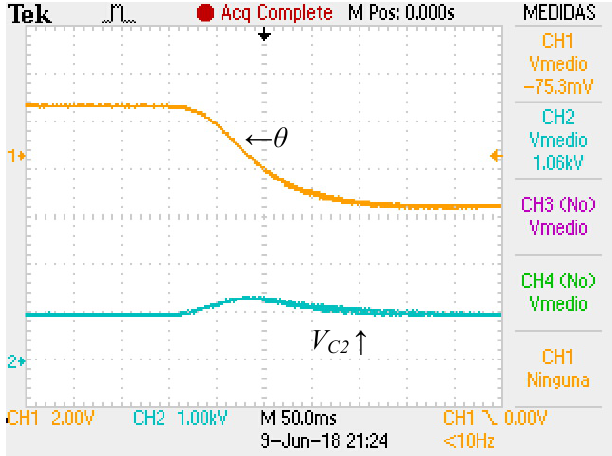
Figure 19. DAB control signal ( θ ) and V C 2